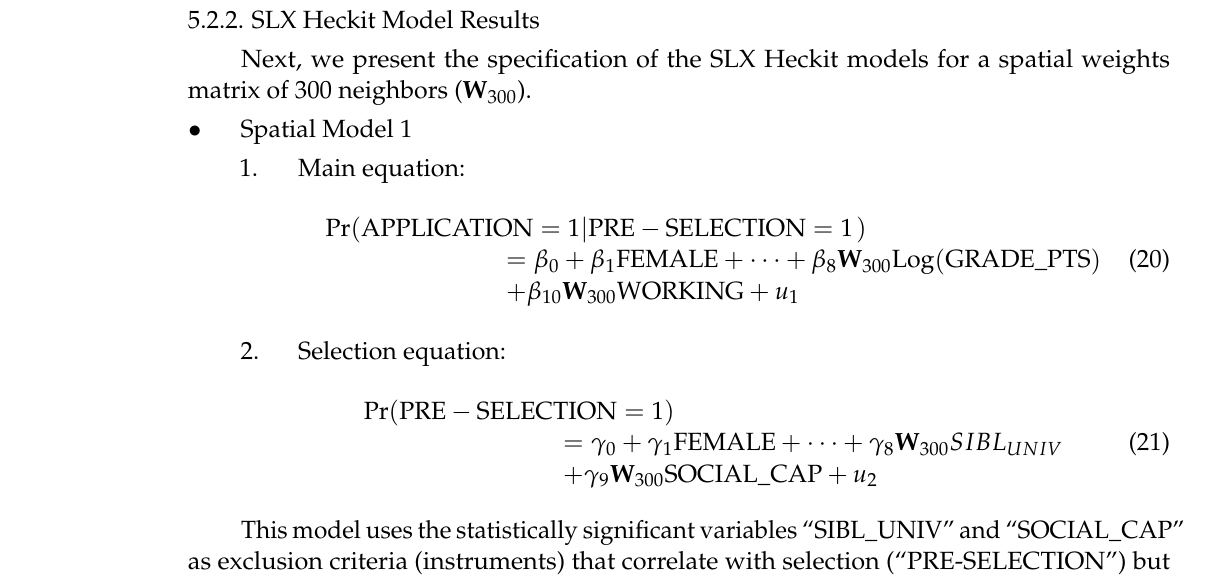
Figure 5. Moran’s I test on the model residuals for W 300 . ( a ) Baseline model; ( b ) Spatial